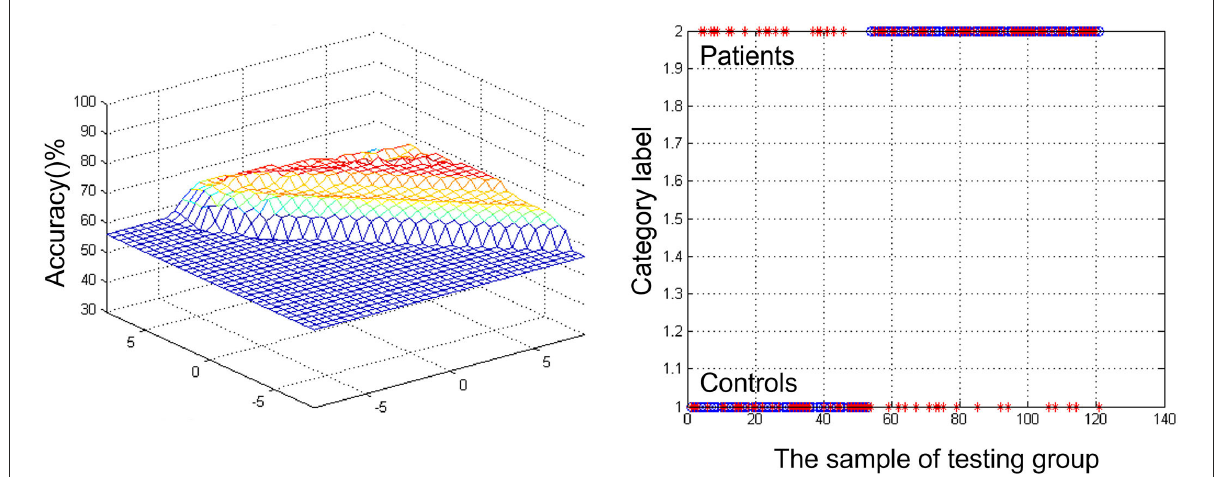
FIGURE2 Visualizing classifications based on support vector machine (SVM) by the decreased regional homogeneity (ReHo) values in the right caudate to discriminate patients with mild cognitive impairment (MCI) from healthy comparisons. (Left) SVM parameters’ result of 3D view. (Right) Classified map of the ReHo values in the right